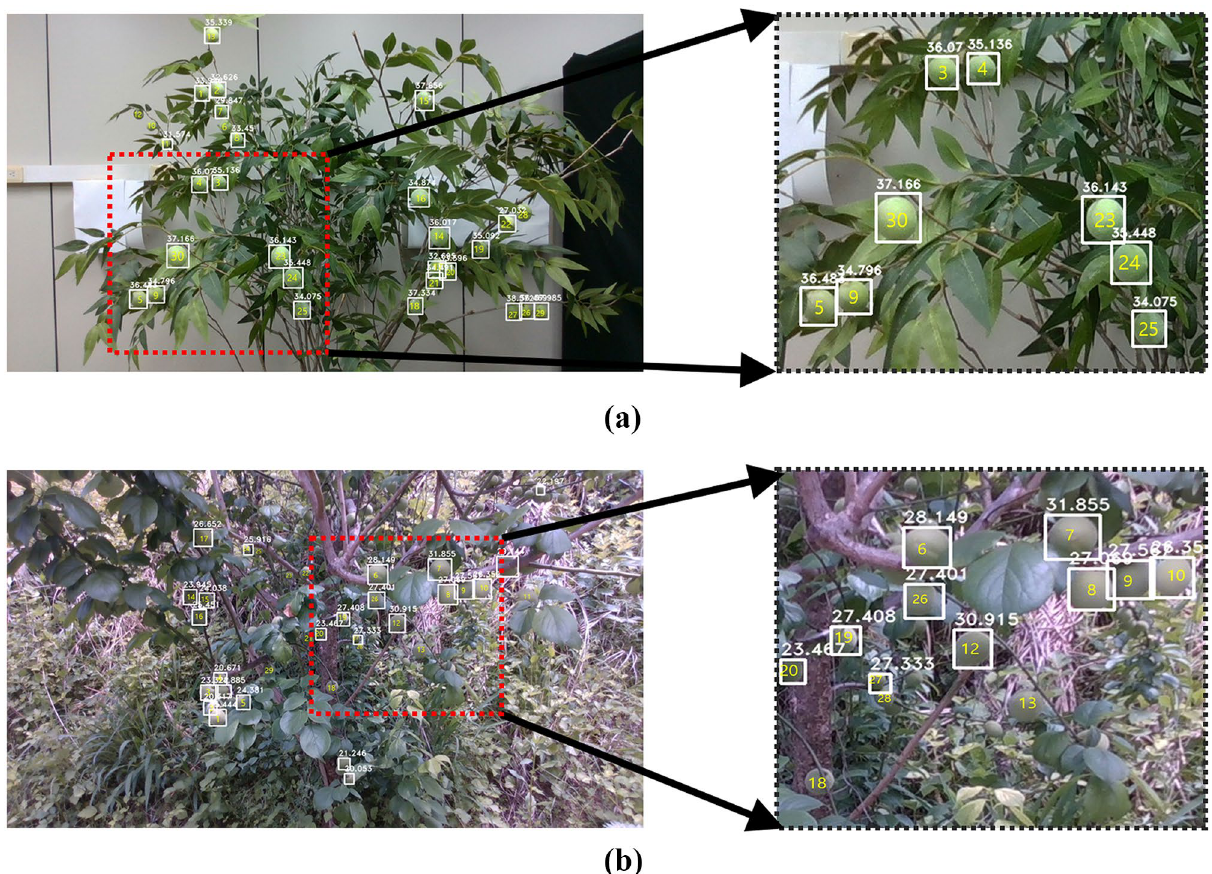
Figure 5. Calculation of each numbered objects’ diameter using depth information: ( a ) indoor; ( b ) outdoor test